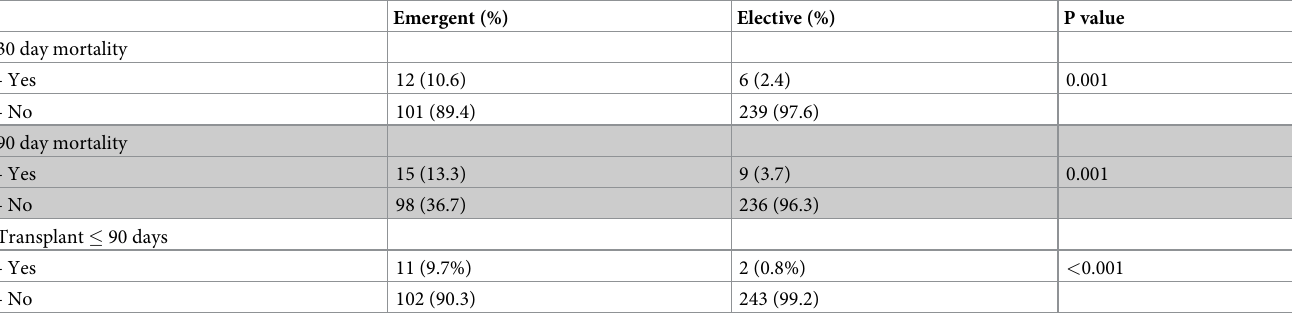
Table 5. Emergent vs. Elective mortality and 90 day transplant rates.